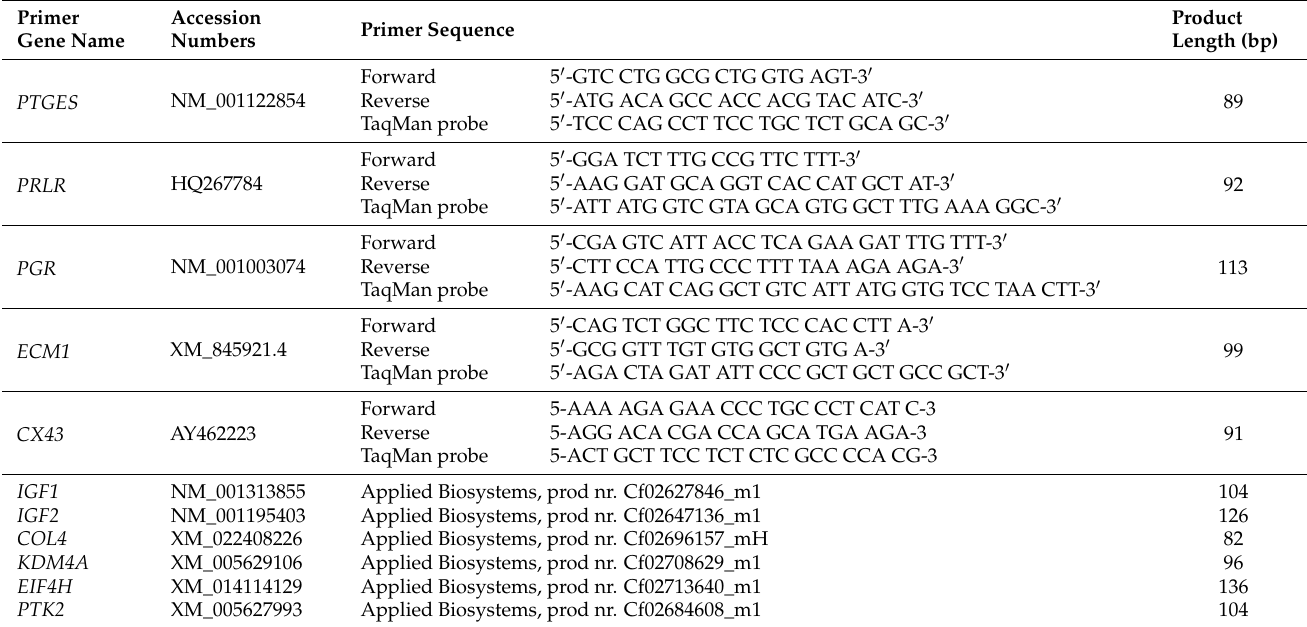
Table 1. List of all TaqMan system used for the semi-quantitative